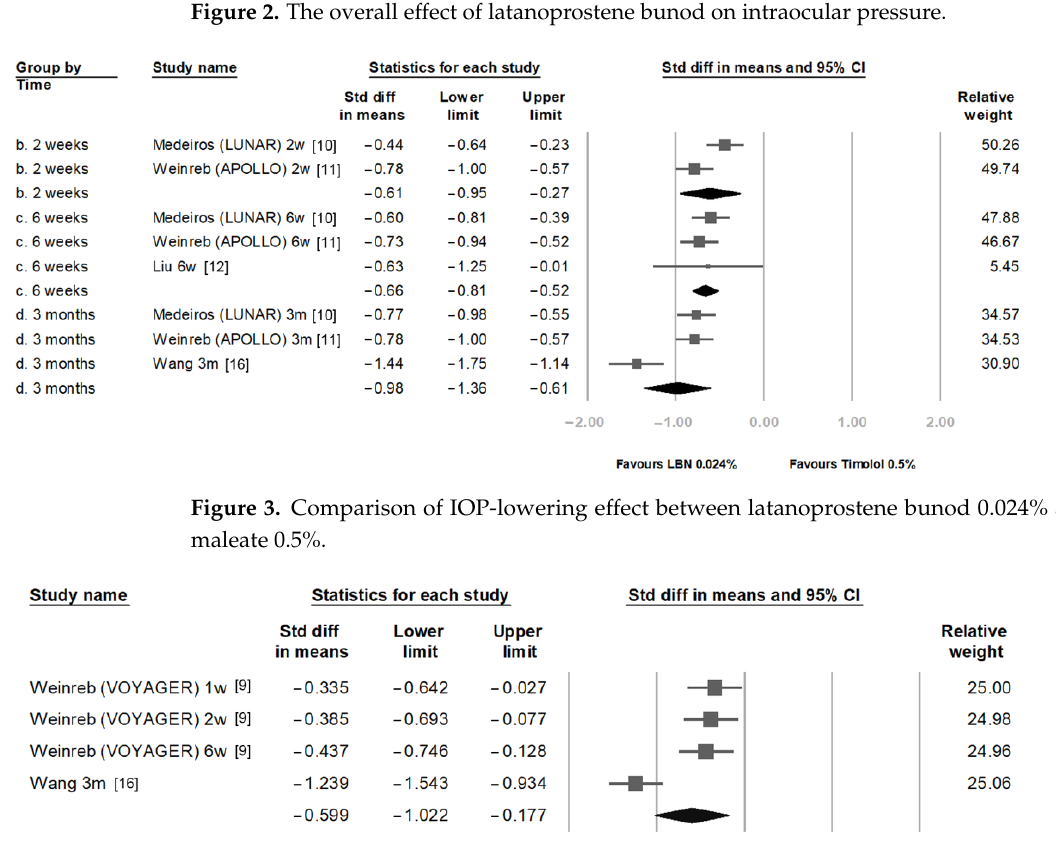
Figure 2. The overall effect of latanoprostene bunod on intraocular pressure.